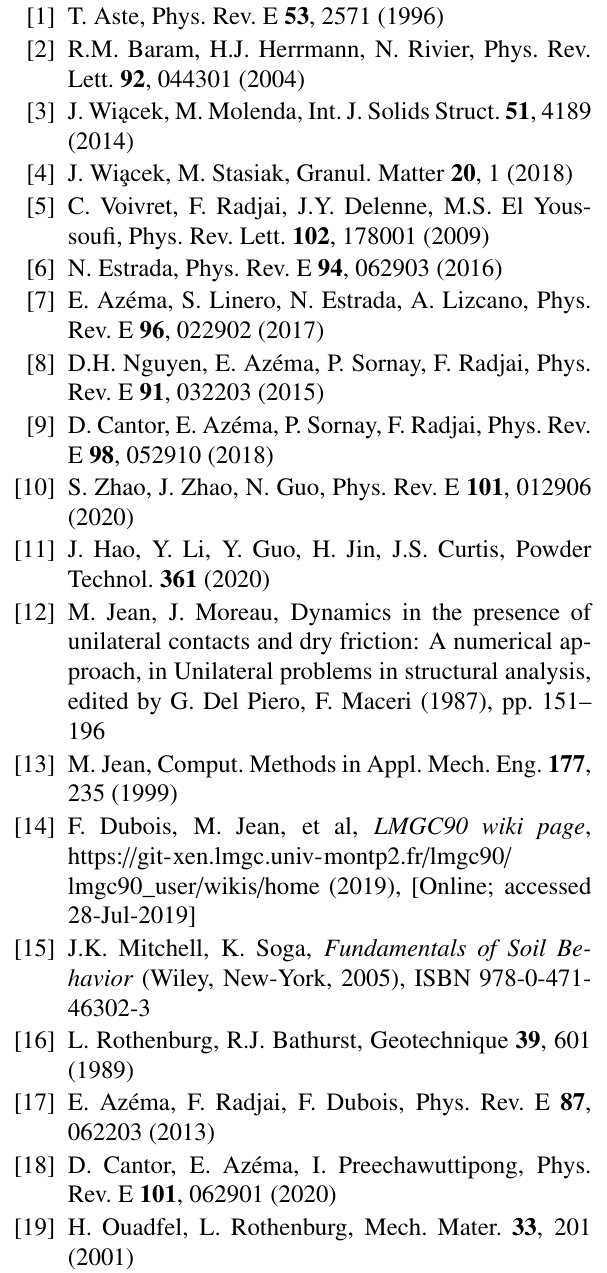
Figure 5. Evolution of the normal and tangential force anisotropies ( a fn , a ft ) as a function of the particle size span S . Bars represent the standard deviation of the